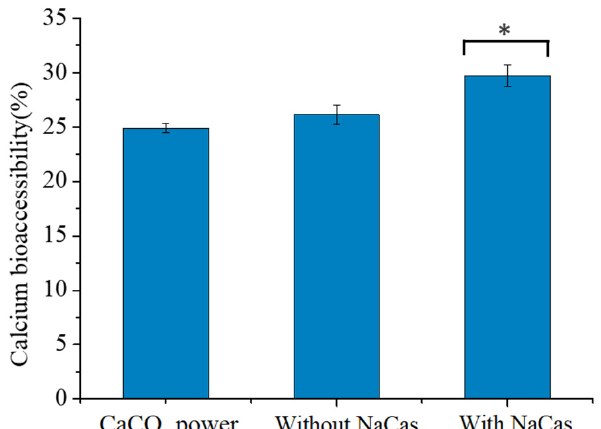
Figure 7. Soluble calcium concentration in the micelle phase and calcium bioaccessibility of pure CaCO 3 powder and CaCO 3 S/O/W emulsion. * p < 0.05